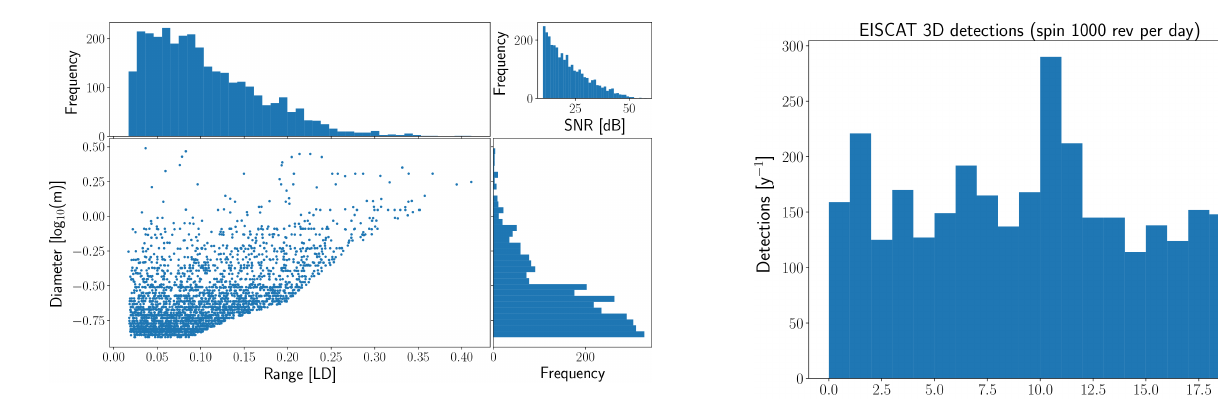
Figure 8. Distribution of ranges and sizes of possible observation windows. Also included is the distribution of peak SNR for these observation windows.